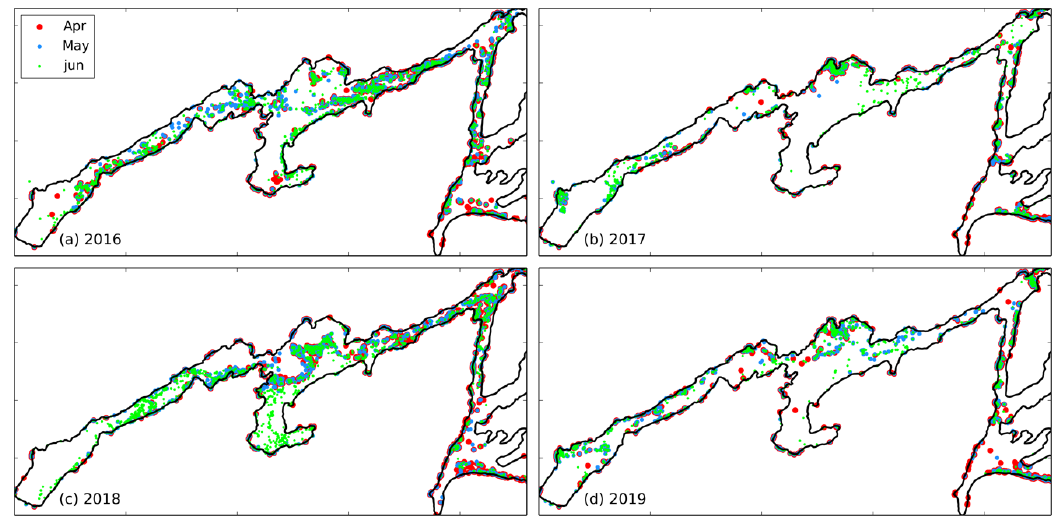
Figure 7. Final particle positions on 30 June for basin-wide seedings on 1 April, May and June of each year for ( a ) 2016, ( b ) 2017, ( c ) 2018 and ( d ) 2019.